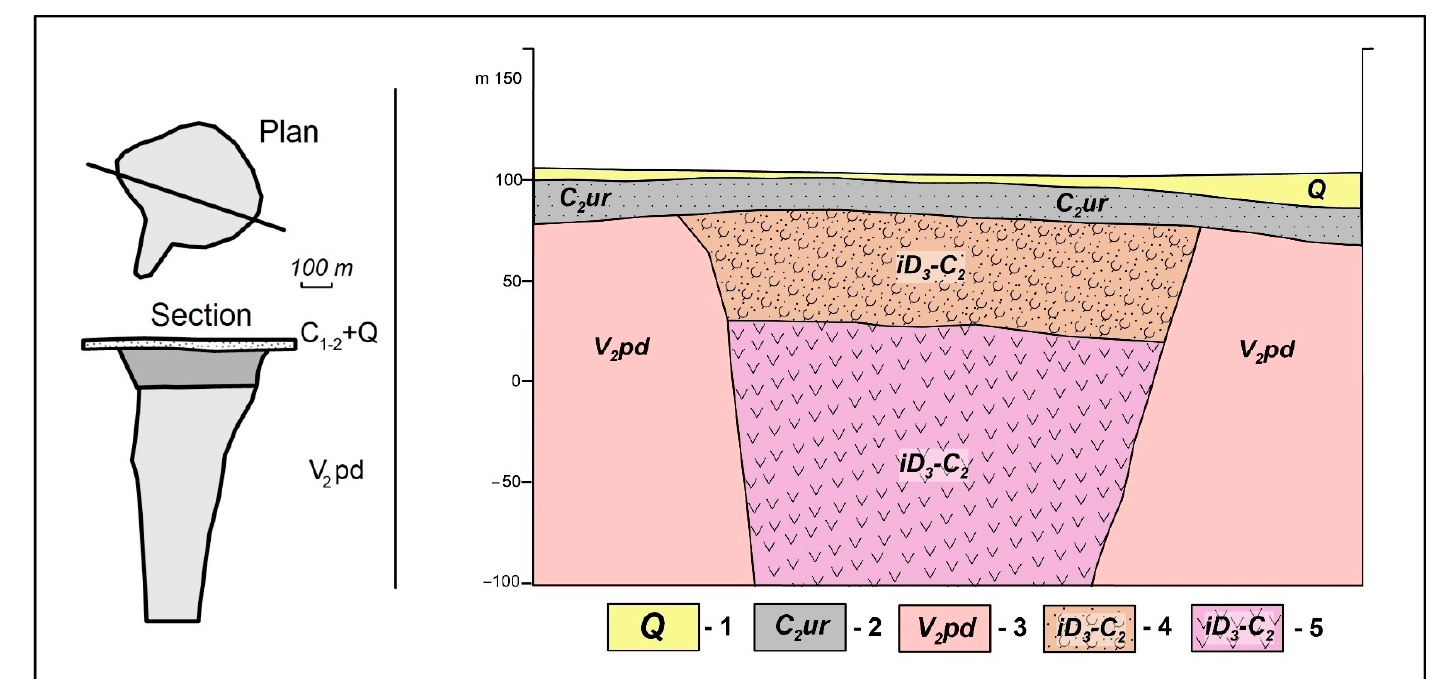
Figure A1. Typical geology cross-section of kimberlite pipe of the Lomonosov diamond deposit. 1—Quaternary fluvioglacial sediments; 2—Middle Carboniferous sediments (Ursug suite); 3—Upper Vendian sediments (host rocks of the near-pipe space); 4—Tuffaceous-sedimentary rocks of the crater facies; 5—Kimberlites of the vent facies.